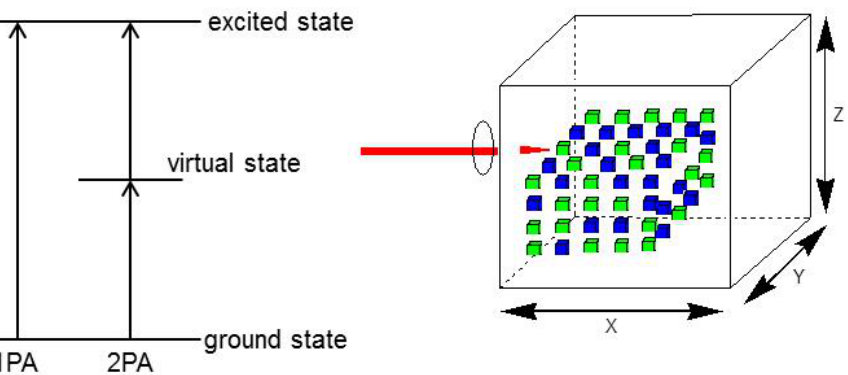
Figure 1. Energy diagram for one-photon and two-photon absorption (left side) and schematic drawing of 3D optical memory using two-photon